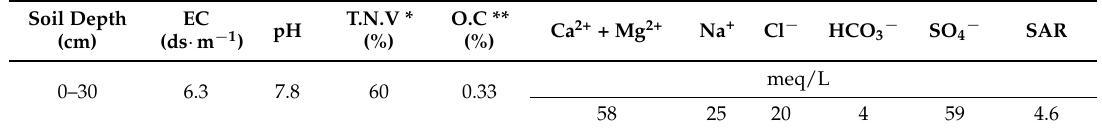
Table 1. Chemical characteristics for soil of experimental field before implementation of experiment.